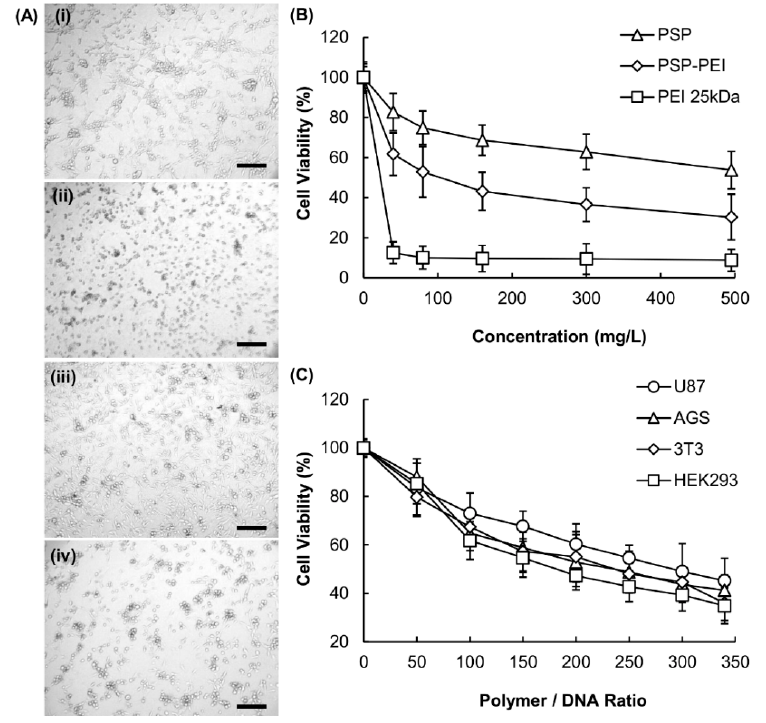
Figure 6. ( A ) Morphologies of U87 cells after transfection with (i) DNA alone, or with polyplexes generated from (ii) PEI 25 kDa, (iii) PSP, and (iv) PSP-PEI. The polymer/DNA ratios adopted for PEI 25 kDa, PSP, and PSP-PEI are 2/1, 250/1, and 250/1, respectively. The scale bar is 200 μ m. ( B ) Viability of U87 cells treated with different concentrations of PEI 25 kDa, PSP, and PSP-PEI. ( C ) Viability of different cell lines treated with polyplexes formed between PSP-PEI and DNA at different polymer/DNA mass-to-mass